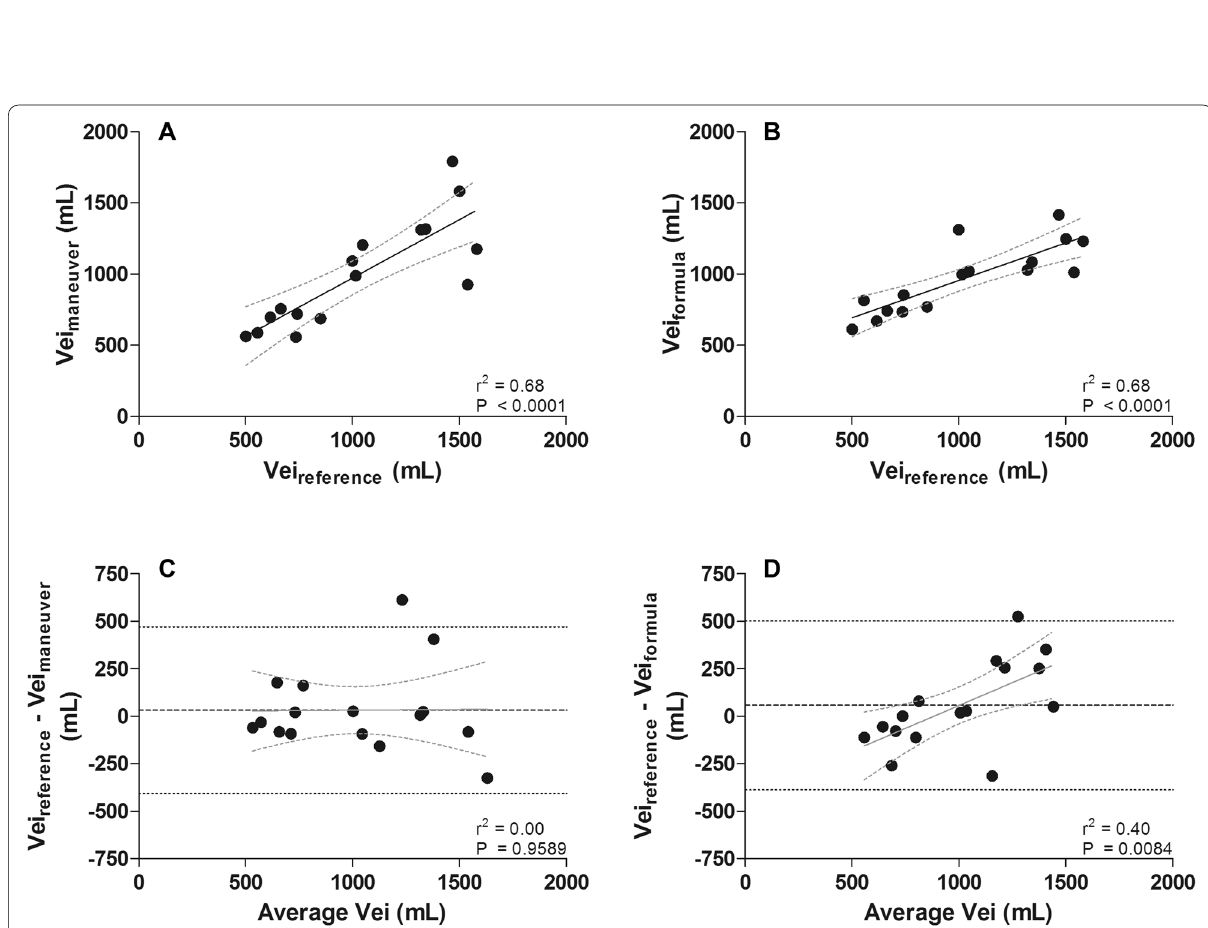
Fig. 5 Bedside techniques to quantify dynamic pulmonary hyperinflation compared with the gold standard (Vei reference ). Fairly good correlations were found between Vei reference and Vei maneuver ( A ) and between Vei reference and Vei formula ( B ). Bland–Altman analysis showed low bias and wide limits of agreement between Vei reference and Vei maneuver ( C ) and between Vei reference and Vei formula ( D ). Furthermore, there is a relationship in the bias between Vei reference and Vei formula (solid line with dashed 95% CI